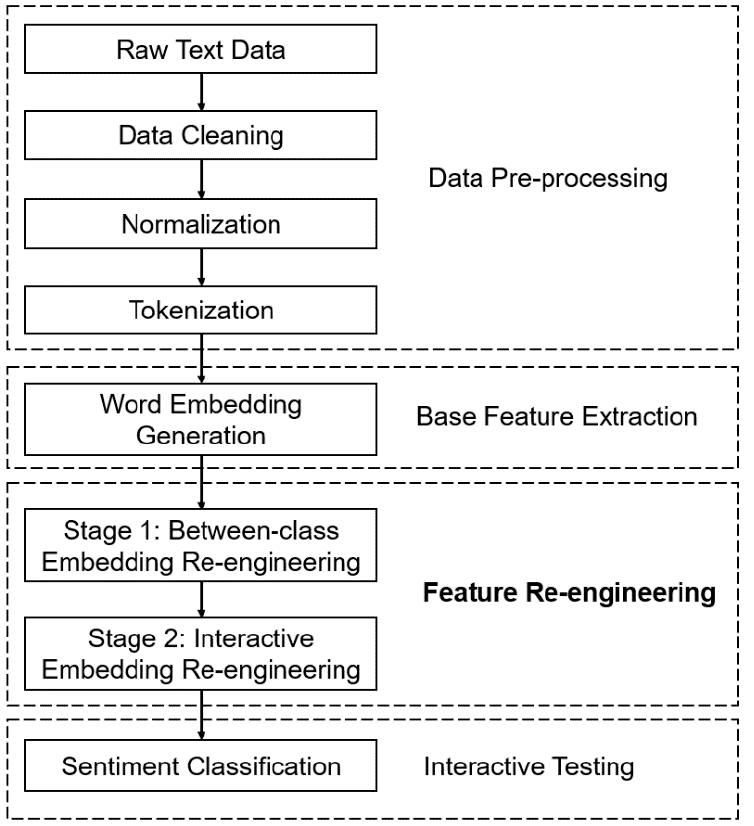
Figure 1. Flow chart diagram of the proposed classification system for sentiment analysis with four main processing modules.